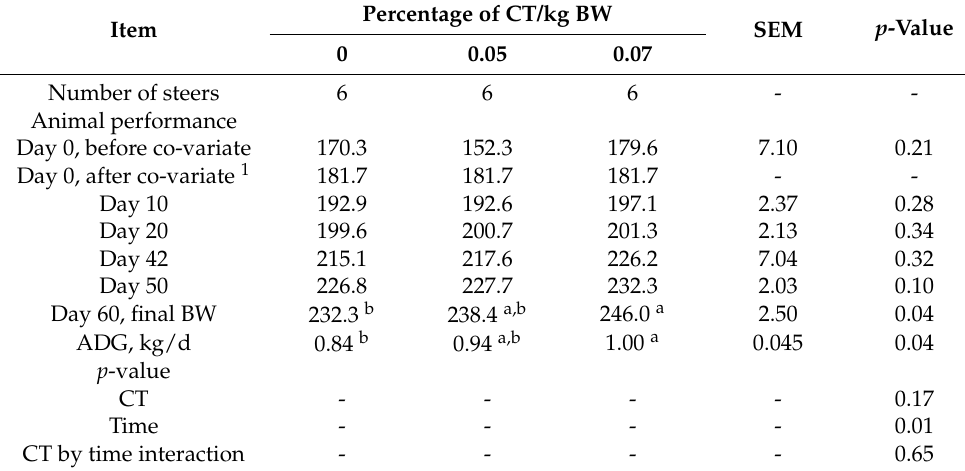
Table 2. Effects of condensed tannins (CT) on the animal body weight (BW) changes and average daily gain (ADG) in rumen-cannulated steers grazing wheat forage.